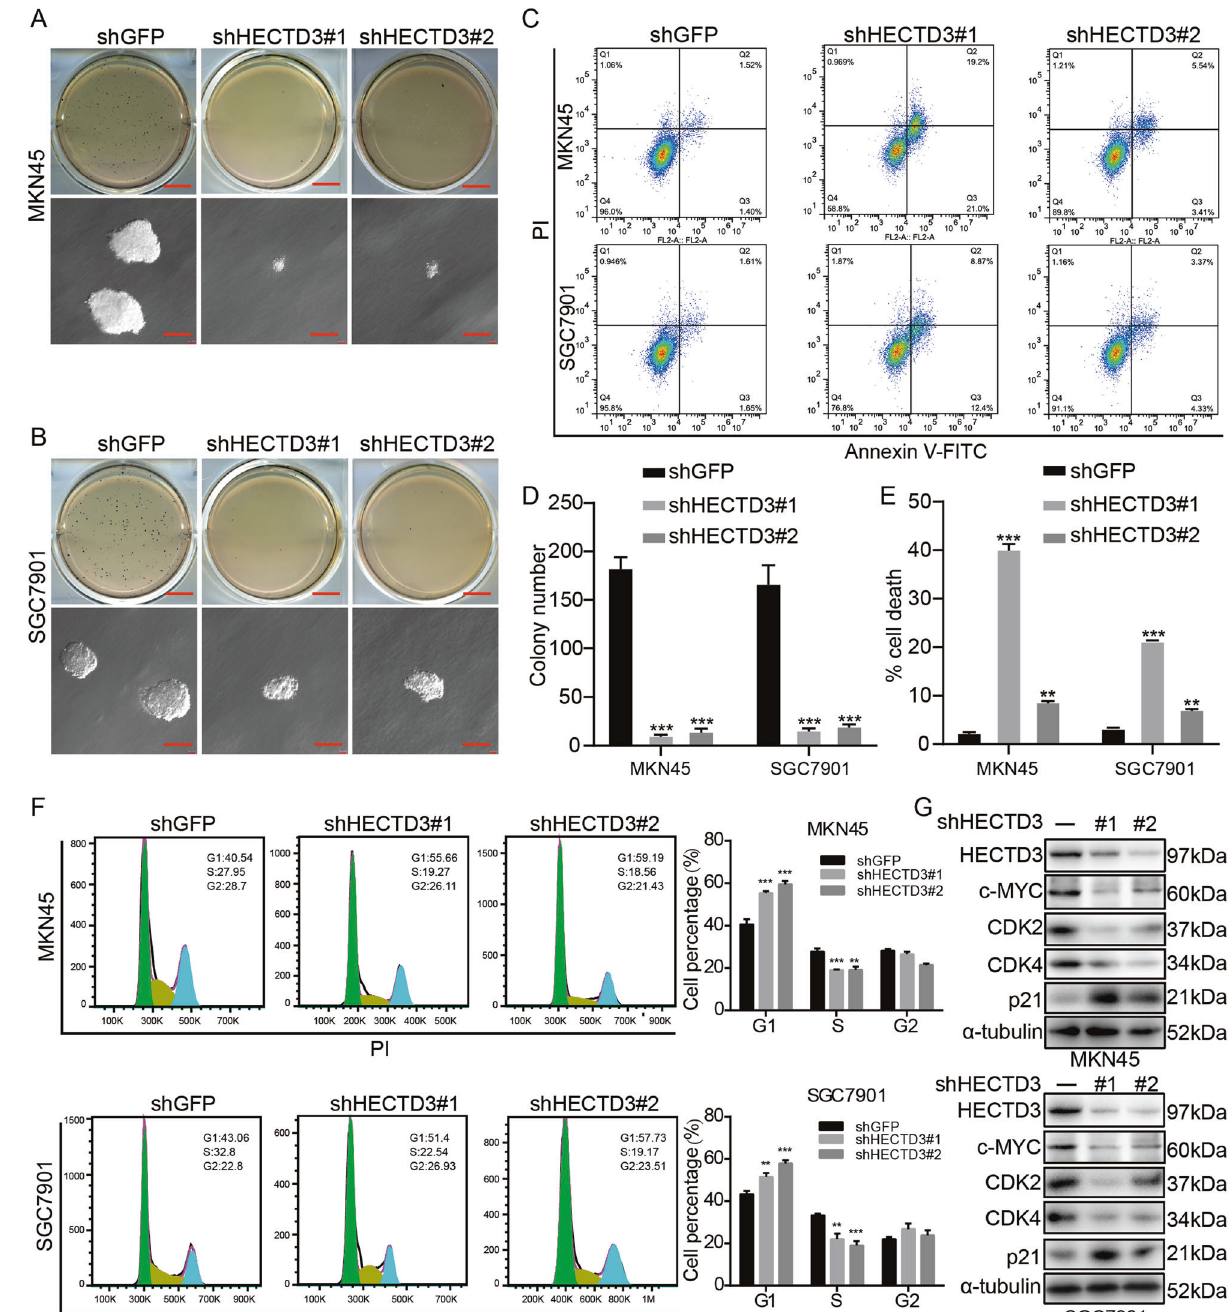
Fig. 3 Depletion of HECTD3 blocks the cell cycle and induces cell apoptosis. A , B , D Clone-forming ability was observed in knocking down HECTD3 cells. C , E Apoptosis of gastric cancer cells with HECTD3-knockdown was analyzed using fl ow cytometry. F The cell cycle was analyzed in HECTD3-knock down gastric cancer cells through fl ow cytometry. G Western blot was applied to check the protein level of HECTD3, c-MYC, CDK2, CDK4, p21, and α -Tubulin in HECTD3 knock down cells.